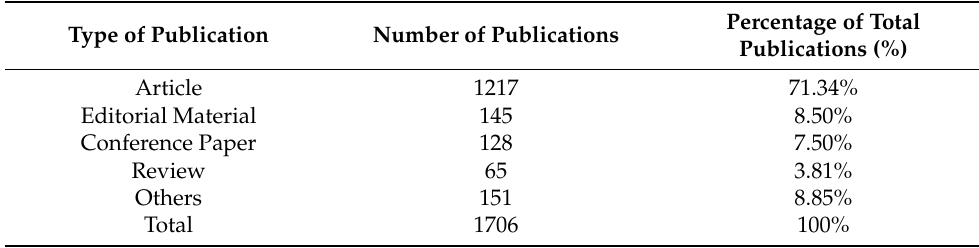
Table 1. Publications by document type.